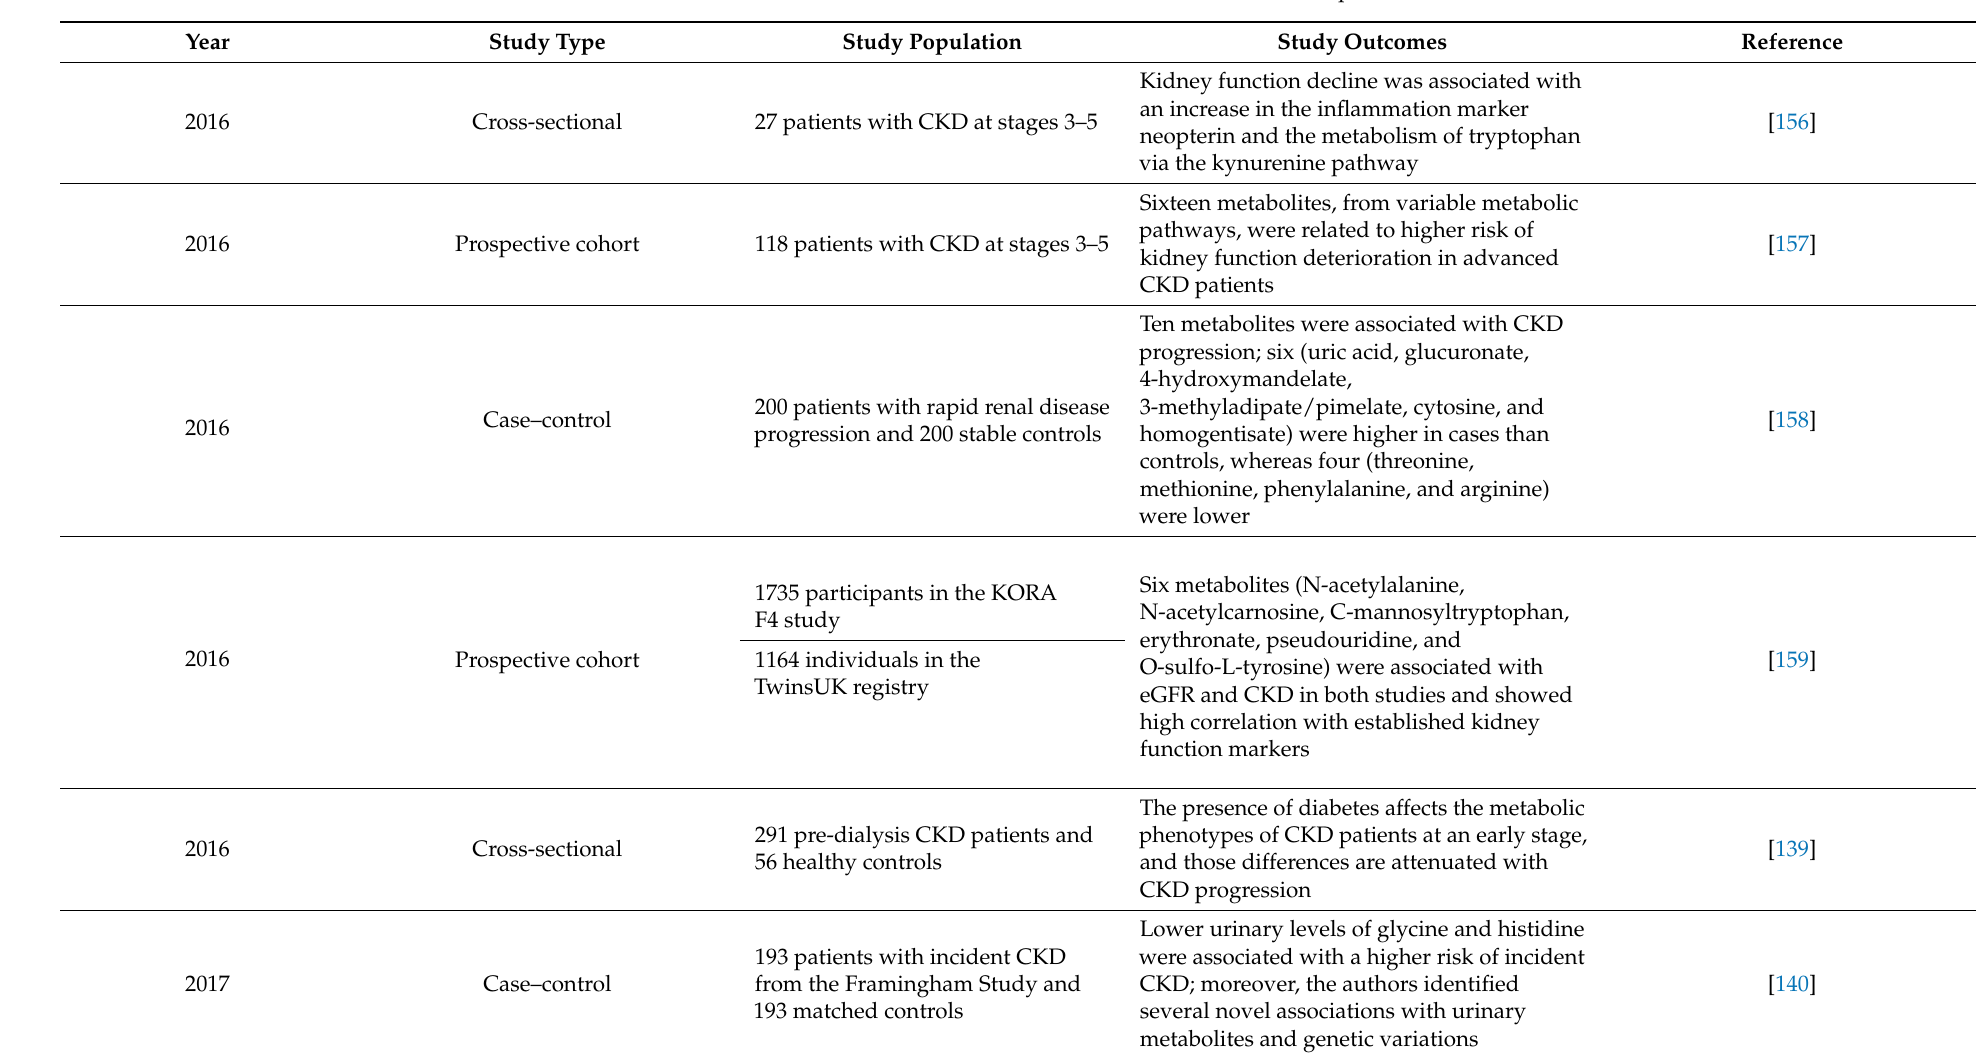
Table 5. Research studies on metabolomics and main outcomes, in CKD